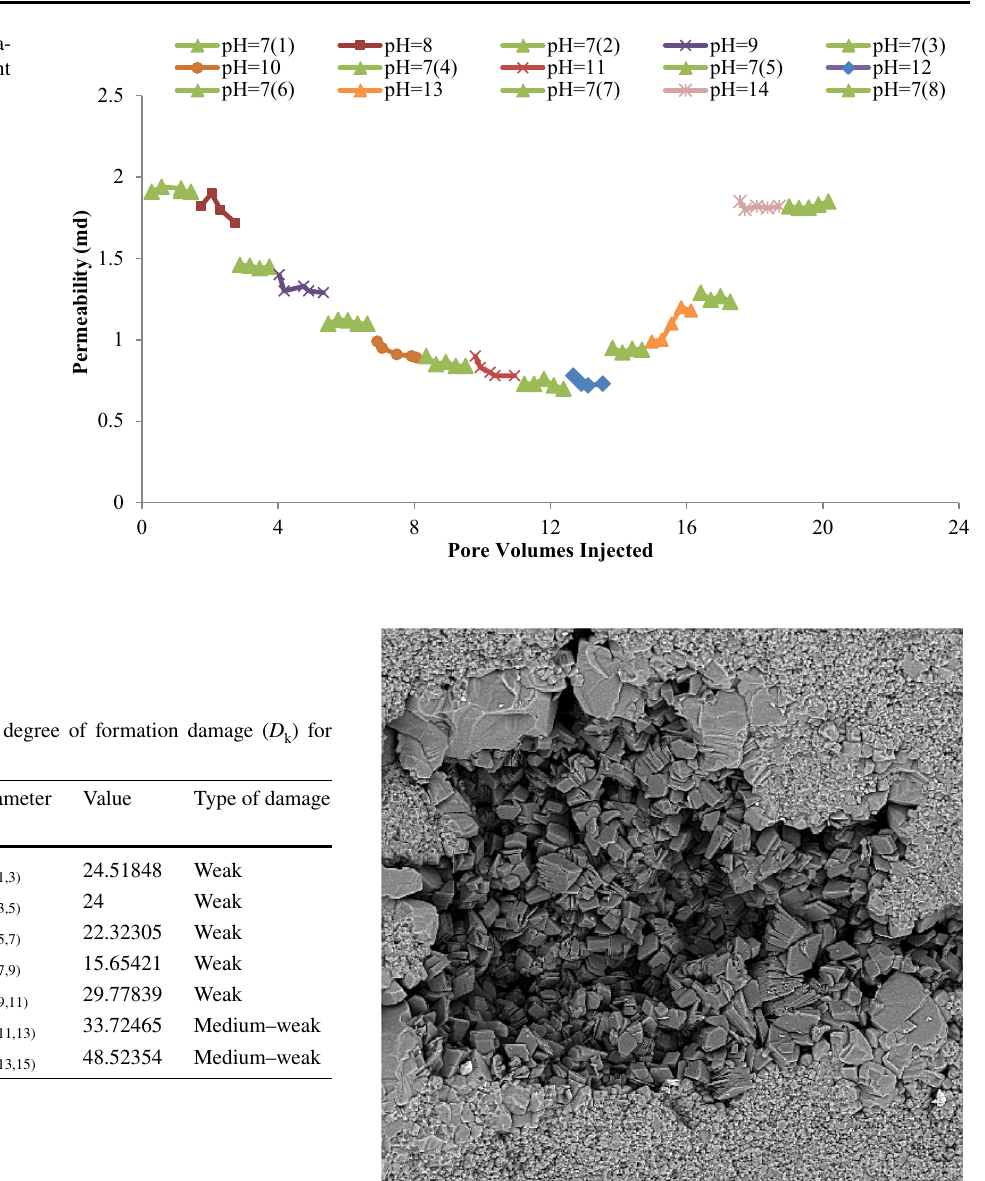
Fig. 10 The permeability altera- tion during injection of different alkaline fluids in core no.3